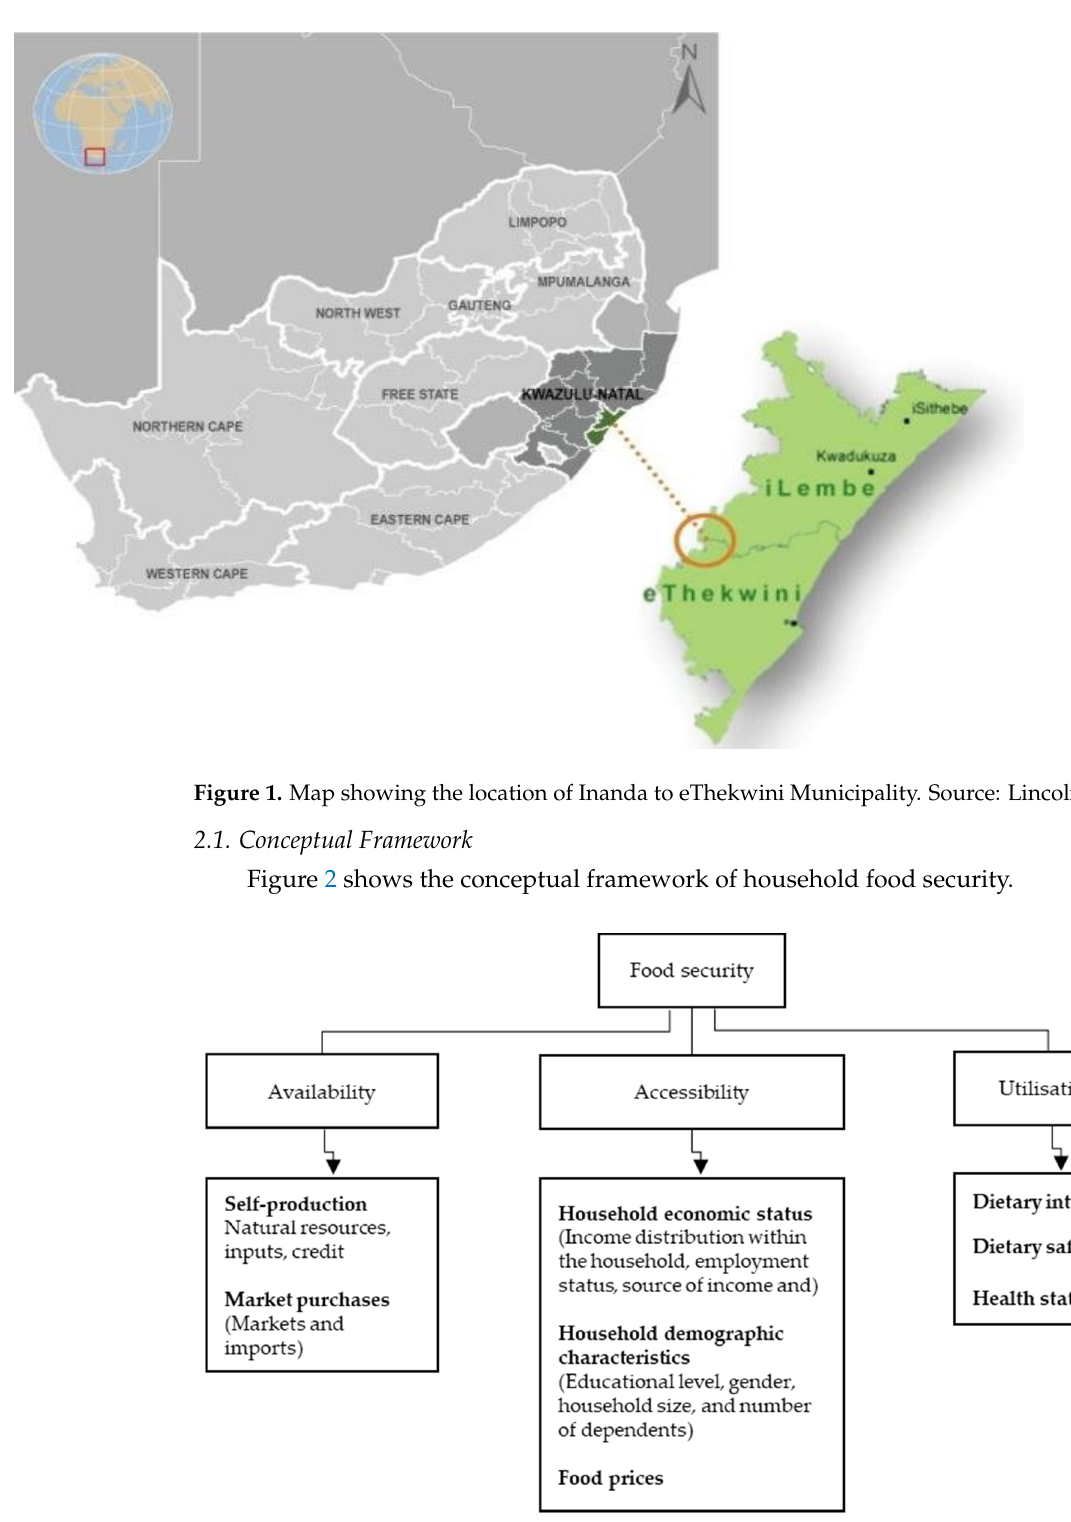
Figure 2. Conceptual framework of household food security. Source: Bashir and Schilizzi [18].